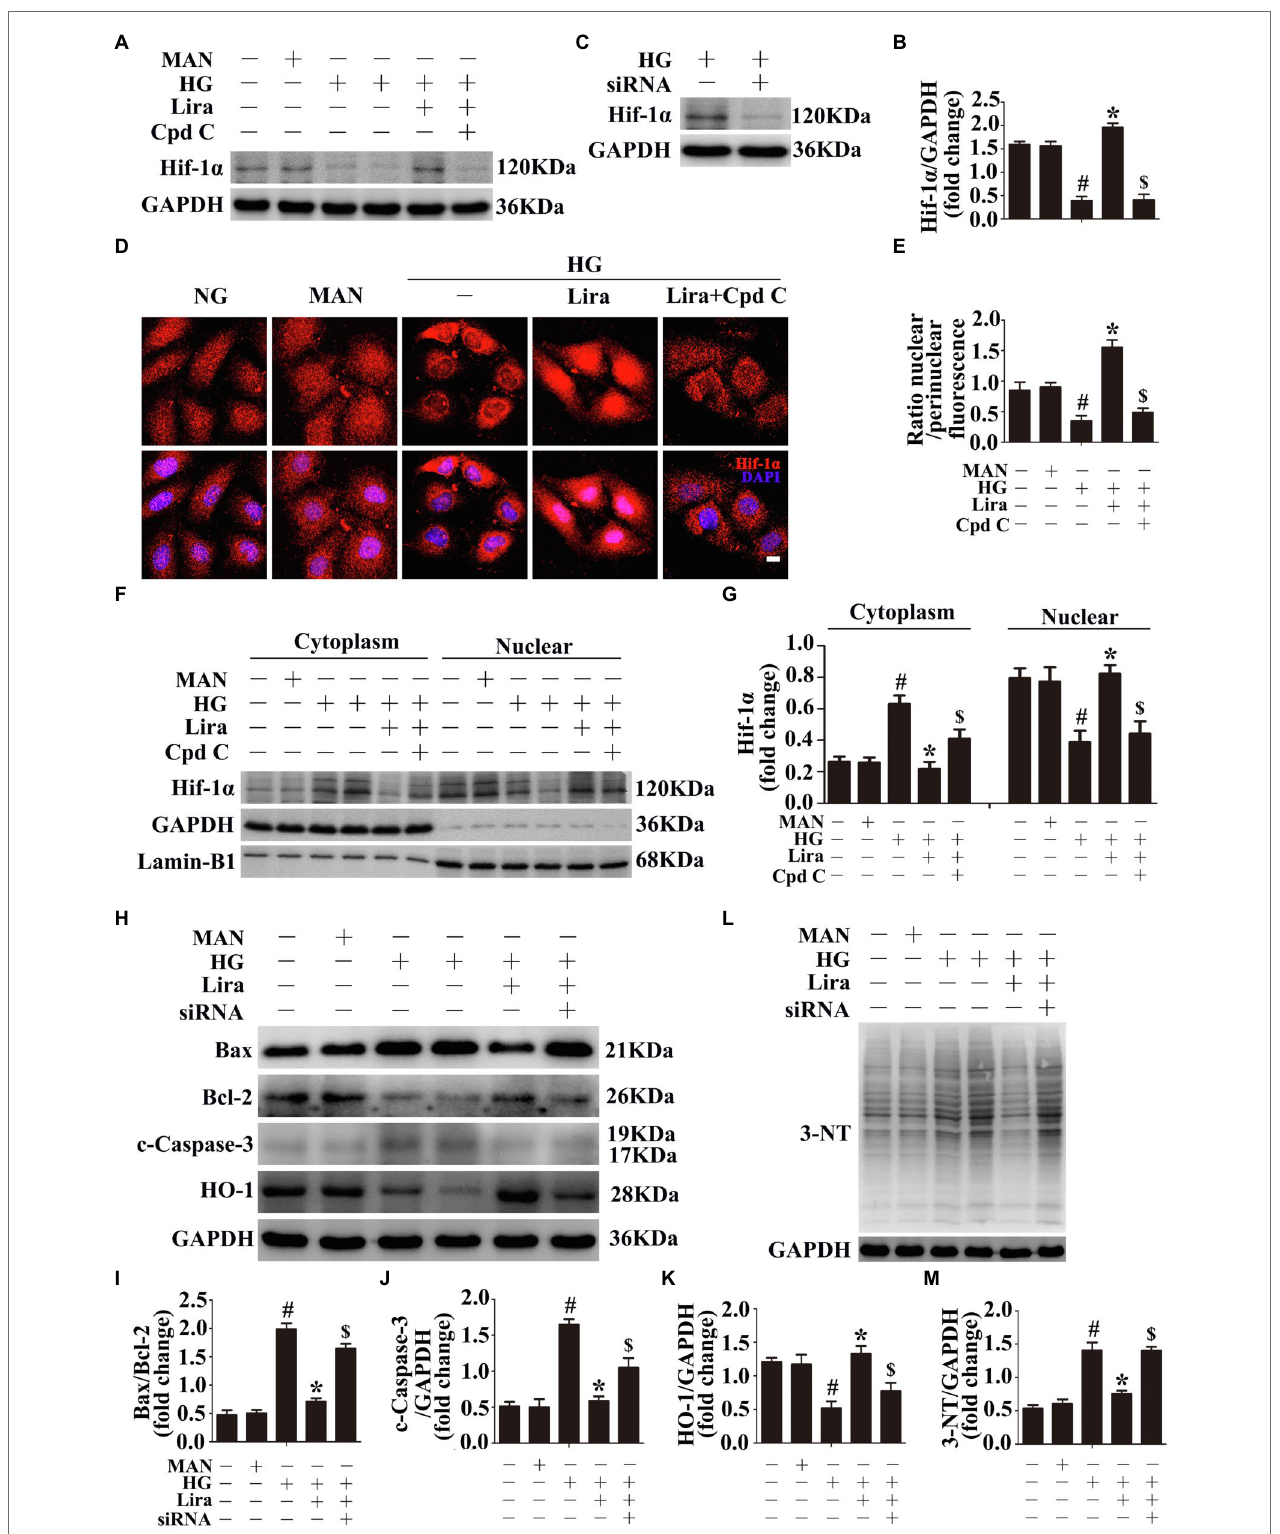
FIGURE 3 | Hypoxia inducible factor-1 α (Hif-1 α ), as the downstream of AMPK, participates in the endothelial protective action of Lira against hyperglycemia, in vitro . (A) Cell lysates of HUVECs were used to detect the Hif-1 α protein levels by immunoblotting. HUVECs were cultured either in NG, or HG medium alone or